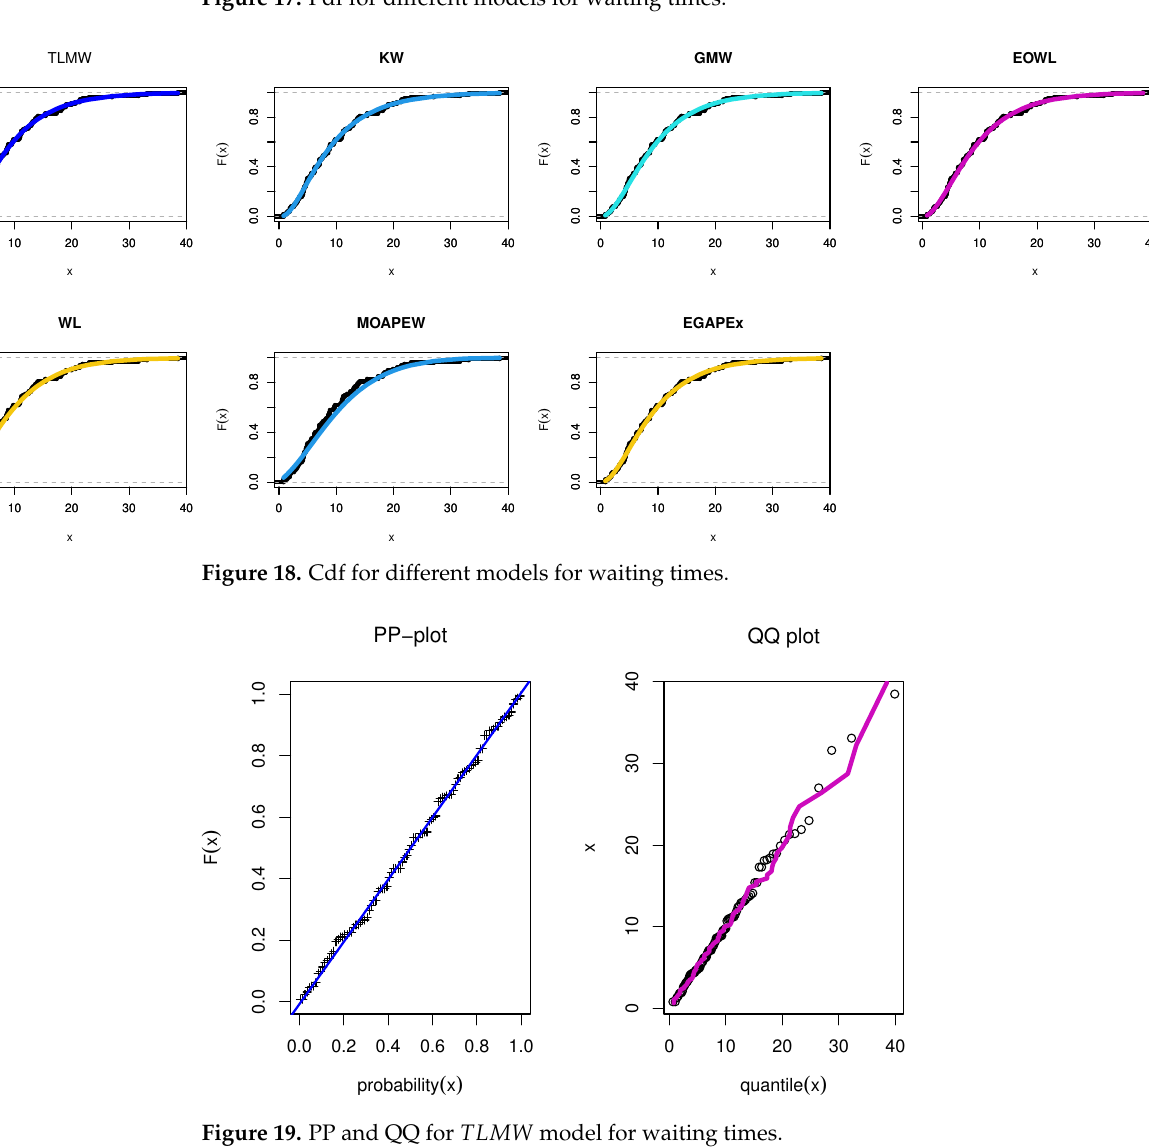
Figure 17. Pdf for different models for waiting times.